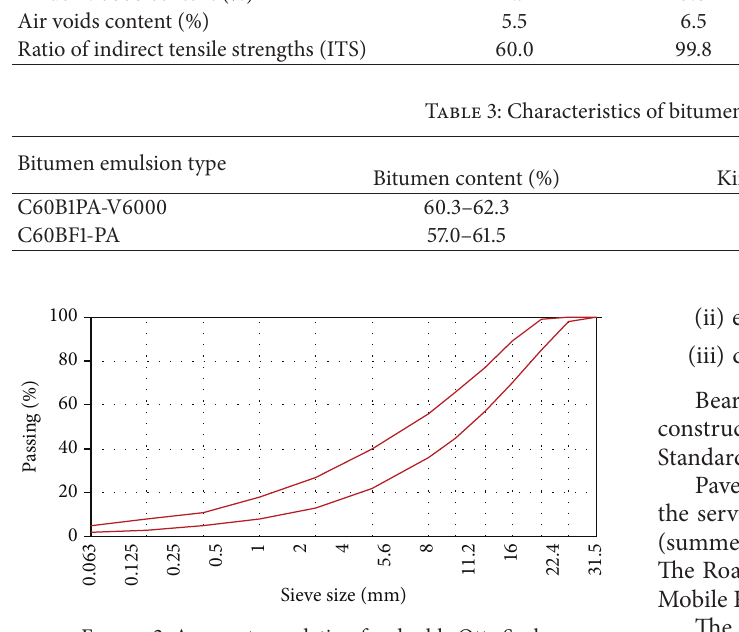
Figure 2: Aggregate gradation for double Otta